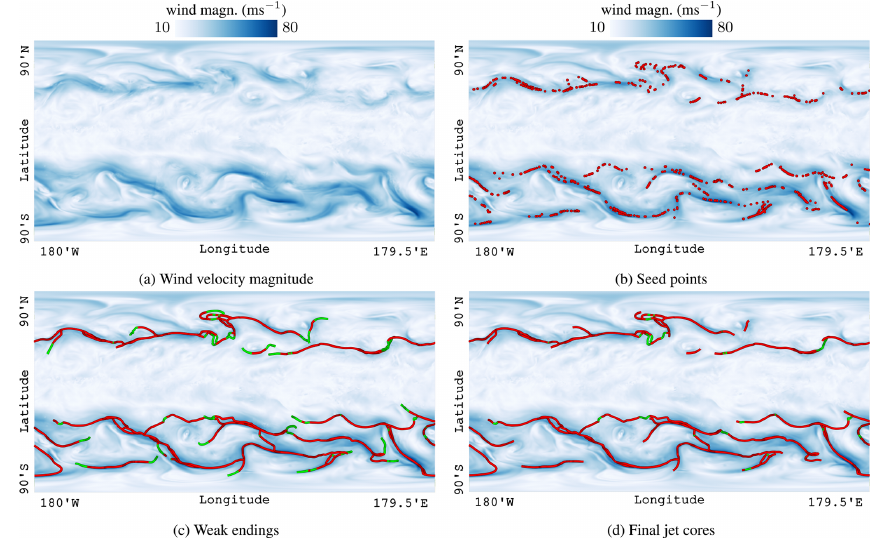
Figure 2. Panel (a) shows a slice of the wind magnitude field. White indicates low wind speed; blue indicates high wind speed. Panel (b) is the same as (a) , overlaying seed points in red. Panel (c) shows predictor–corrector results with weak endings in green. Panel (d) shows the final result, after the weak endings have been removed. Finally, green segments denote regions at which the velocity magnitude threshold was temporarily not reached. The data here are for 8 September 2016 at